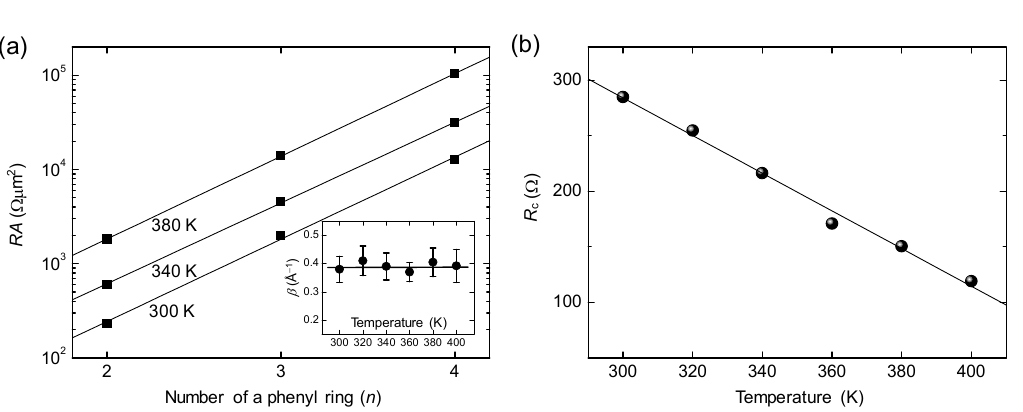
Figure 3. ( a ) Semilog plots of RA versus n . Inset shows β values as a function of temperature. Solid lines indicate linear fits. Error bars denote fitting errors. ( b ) Plot of R c versus temperature. Solid lines indicate a linear fit.